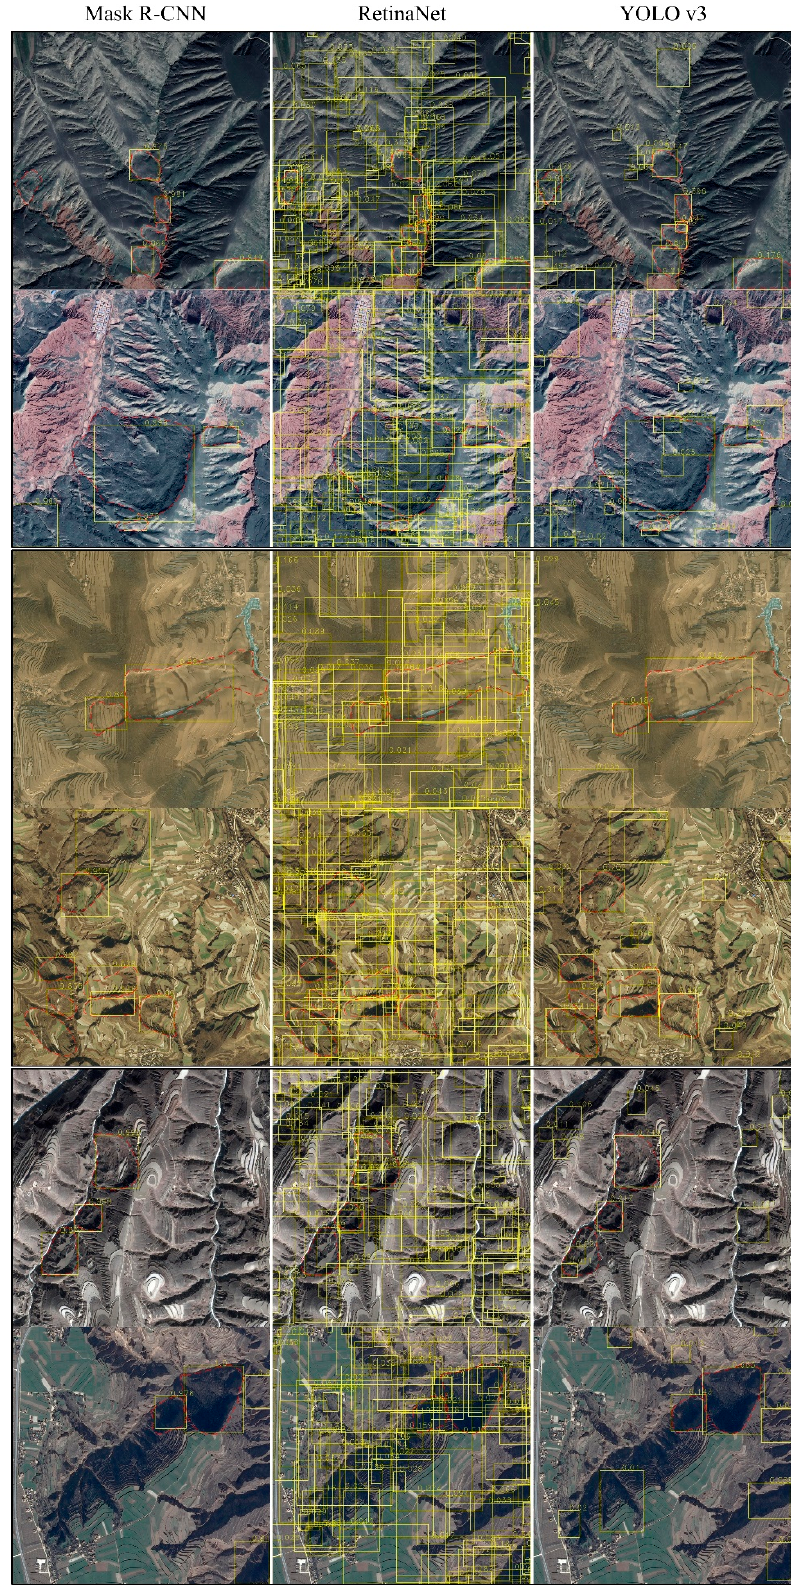
Figure 5. Results of different models.